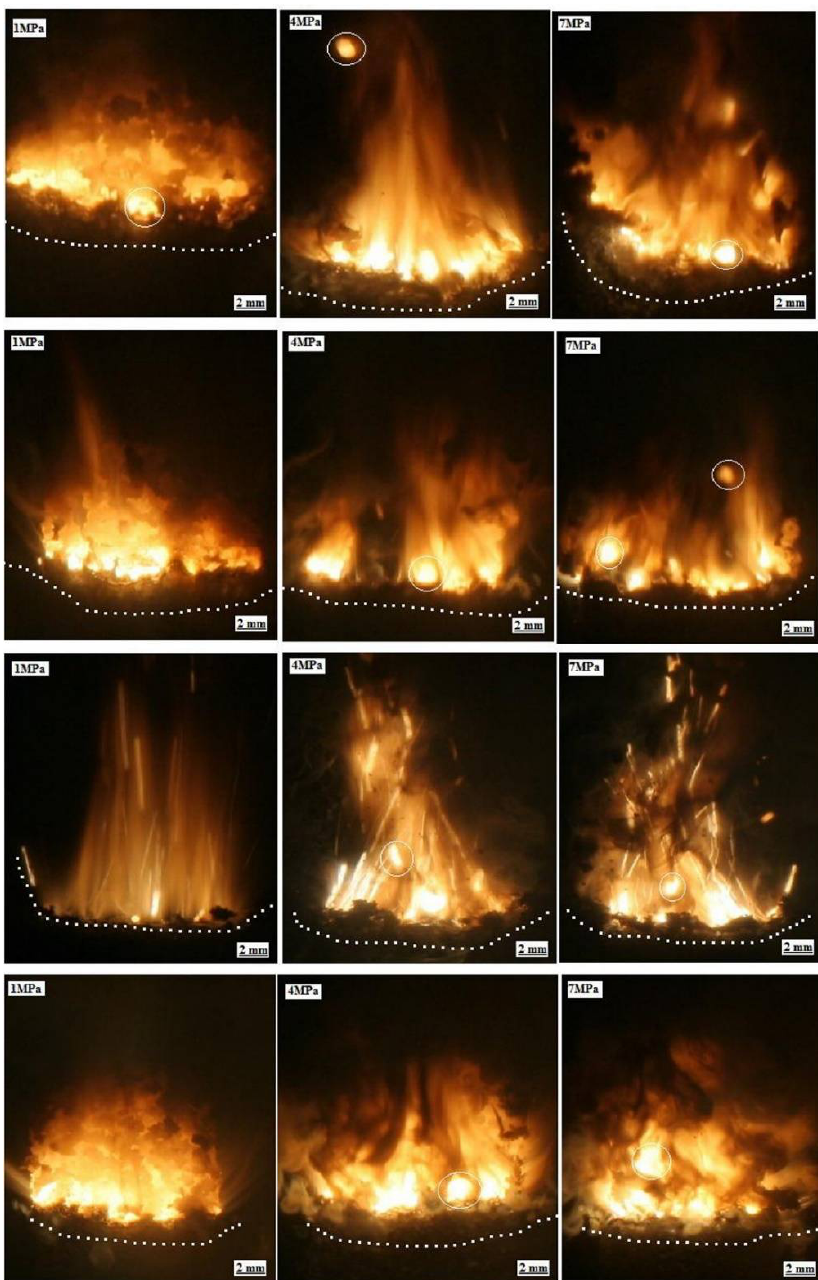
Figure 11. Combustion flame overview propellants with different mass fraction of HIC at pressures 1, 4, and 7 MPa. Top is sample BHF-1, second and third lines are samples BHF-2 and BHF-3, bottom is BHF-4. Reprinted with permission of Elsevier from [82].